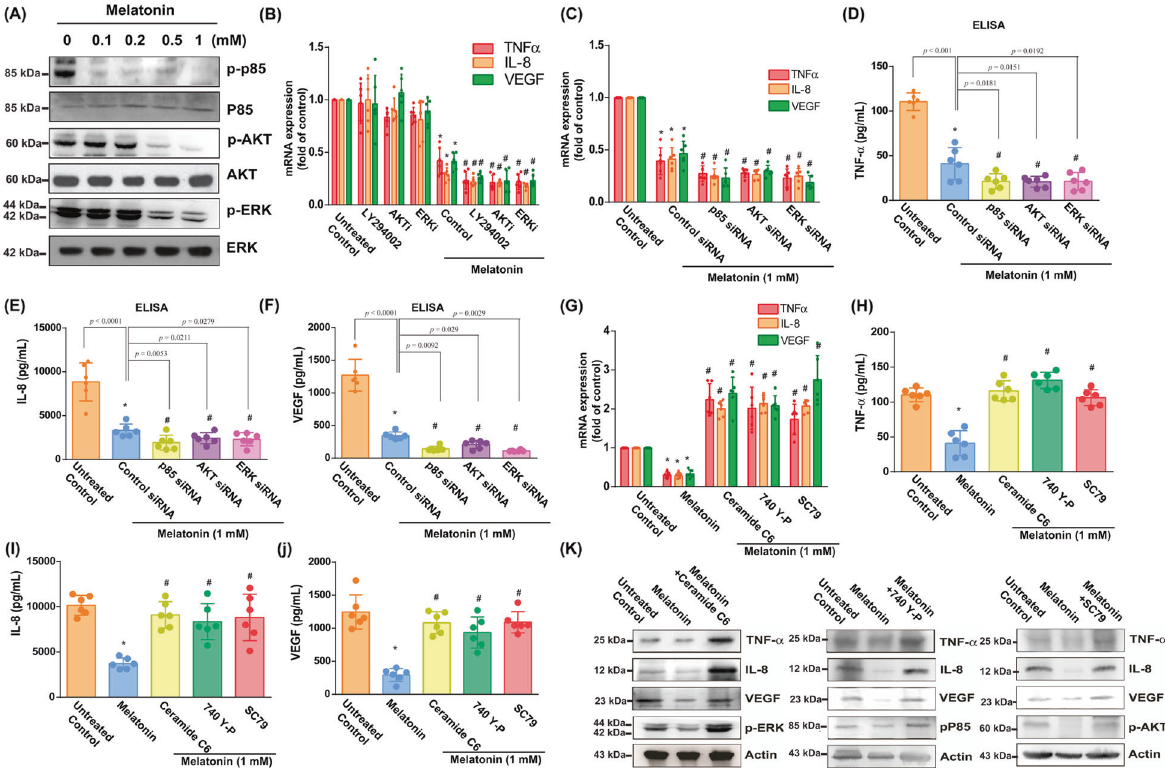
Fig. 3 ERK and PI3K/Akt signaling pathways are involved in melatonin-induced downregulation of proin fl ammatory factors (TNF- α , IL-8, and VEGF). A OASFs were incubated with melatonin (0 – 1 mM) and the Western blot assay ( n = 3) determined p85, Akt, and ERK phosphorylation. B OASFs were treated with pathway inhibitors for 30 min then incubated with 1 mM of melatonin. The qPCR assay ( n = 6) quanti fi ed TNF- α , IL-8, and VEGF expression. C – F OASFs were transfected with siRNAs then incubated with melatonin (1 mM) overnight. qPCR ( n = 6) and ELISA ( n = 6) assays measured TNF- α , IL-8, and VEGF mRNA and protein expression. G – K OASFs were pretreated with activators of ERK (C6-ceramide) 10 μ M, PI3K (740-YP) 10 μ M, and Akt (SC-79) 10 μ M for 30 min, then incubated with melatonin (1 mM). qPCR ( n = 6), ELISA ( n = 6) and western blot ( n = 3) assays determined the expression of TNF- α , IL-8, and VEGF, respectively. Error bars indicate means ± S.D. * p < 0.05 versus controls; # p < 0.05 versus the melatonin-treated